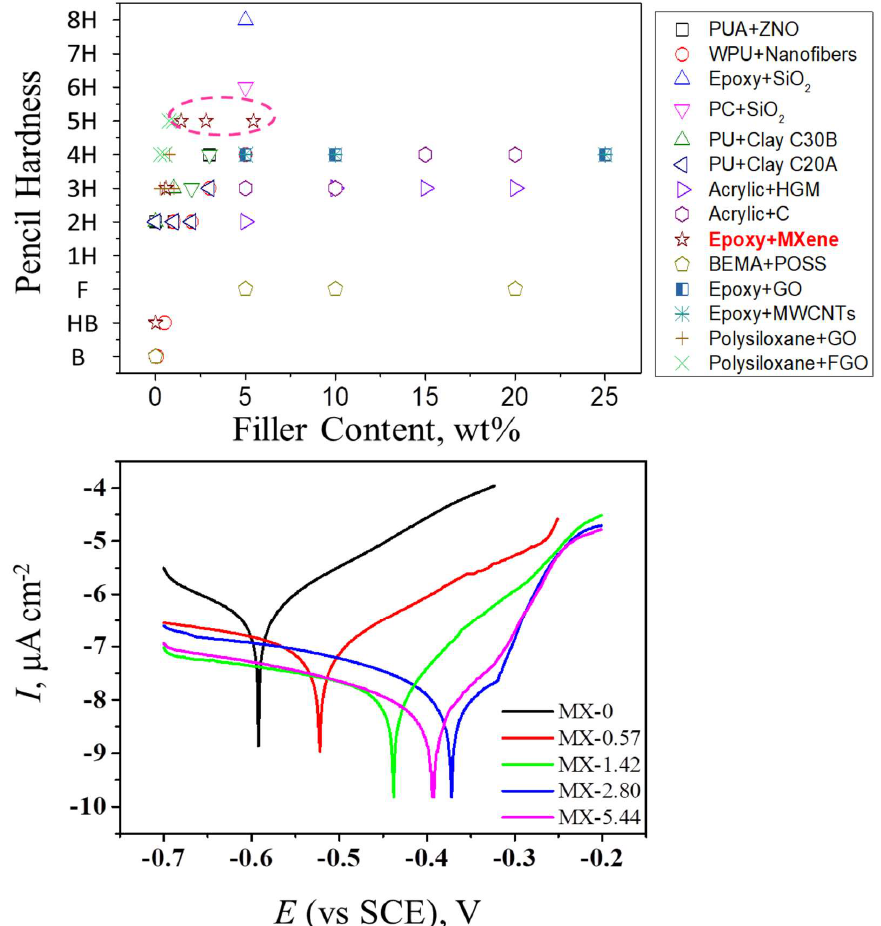
Figure 5. ( a ) Comparison of pencil hardness of different polymer coatings containing varied fillers; ( b ) Tafel plots of MX-0–MX-5.44.